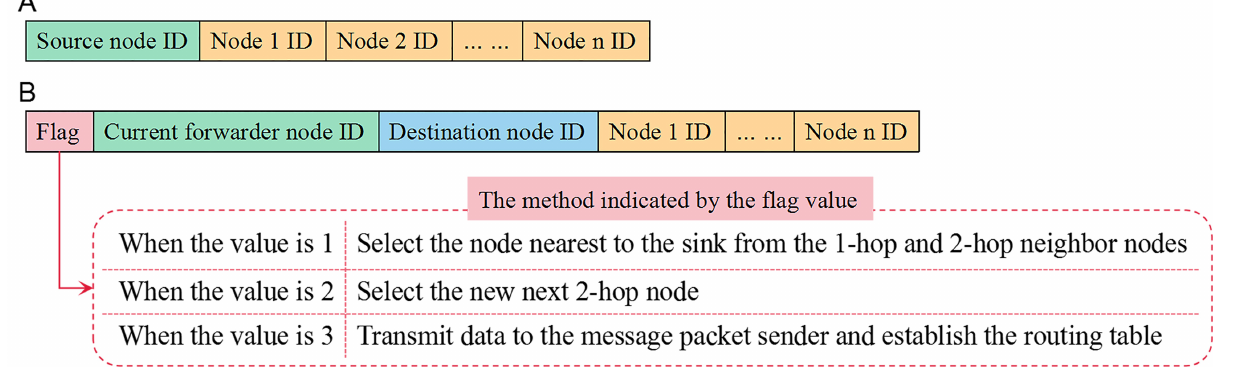
Figure 5. ( A ) The format of the burst packet. ( B ) The format of the message packet and the method indicated by each flag